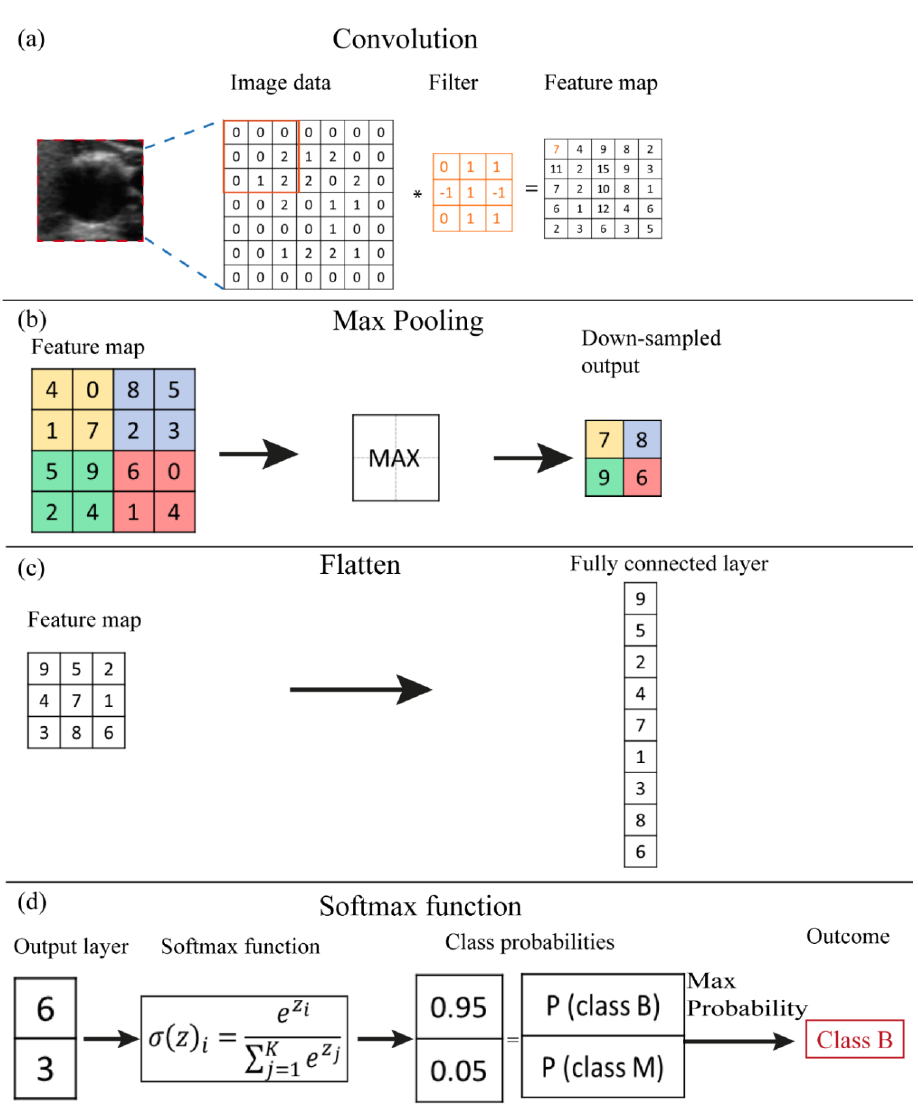
Figure 3. ( a ) Numerical example of the functions that compose the CNN architecture: ( a ) convolution, ( b ) max pooling, ( c ) flattening, ( d ) softmax function.